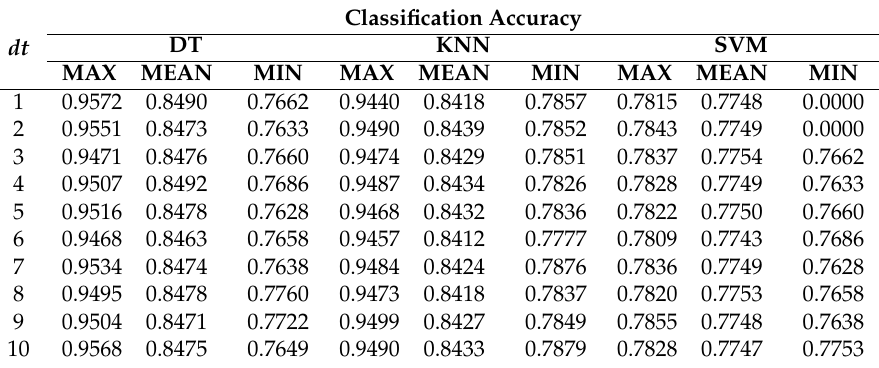
Table 5. Accuracy rate for DT, KNN and SVM classifiers with dt movement.